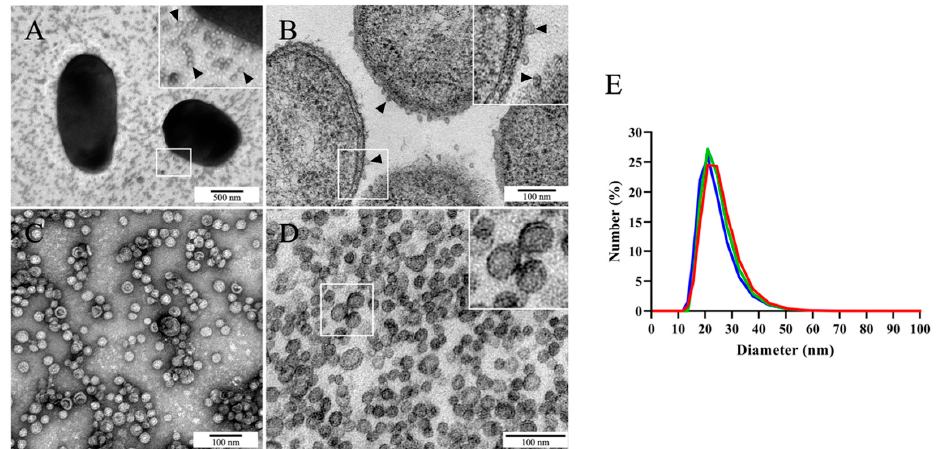
Figure 1. The Phdp European strain MT1415 releases large numbers of OMVs in vitro. ( A ) Transmission electron microscopy (TEM) image of negatively stained MT1415 cells surrounded by high number of small-sized spherical vesicles (some vesicles are indicated by arrowheads). Bacteria were cultured on TSA-1, suspended in 1% NaCl, loaded on the grid, and negatively stained with uranyl acetate. ( B ) TEM of an ultrathin section of an MT1415 colony grown on TSA-1, showing several vesicles at the bacterial cells’ surface (some vesicles are indicated by arrowheads). ( C ) TEM of crude OMVs negatively stained with uranyl acetate. ( D ) Ultrathin section of crude OMVs, showing that the vesicles are surrounded by a single bilayer membrane (inset). ( E ) Particle size distribution of crude OMVs analyzed by dynamic light scattering. Each line in the graph corresponds to the results obtained for an independent batch of crude